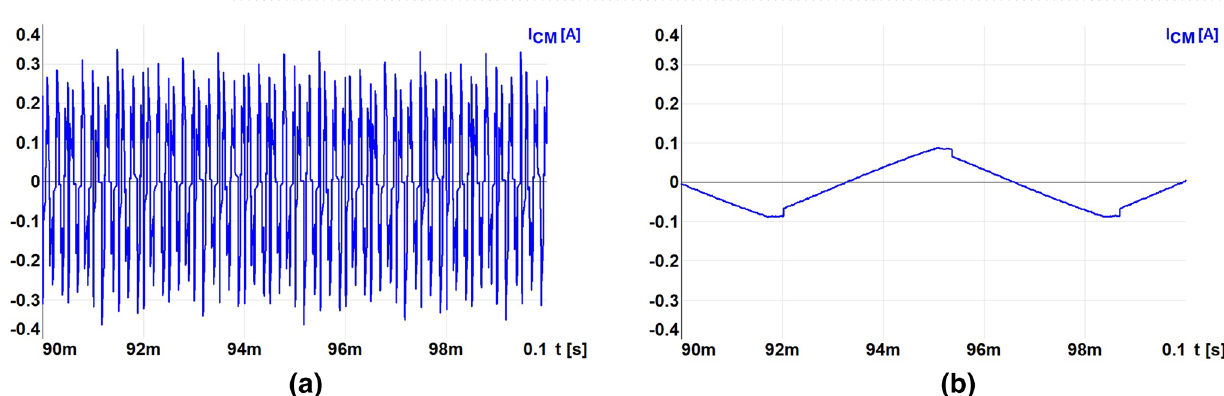
Figure 12. Proposed dedicated circuit for the CM current of the PWM inverter, isolated from the PE protection system.